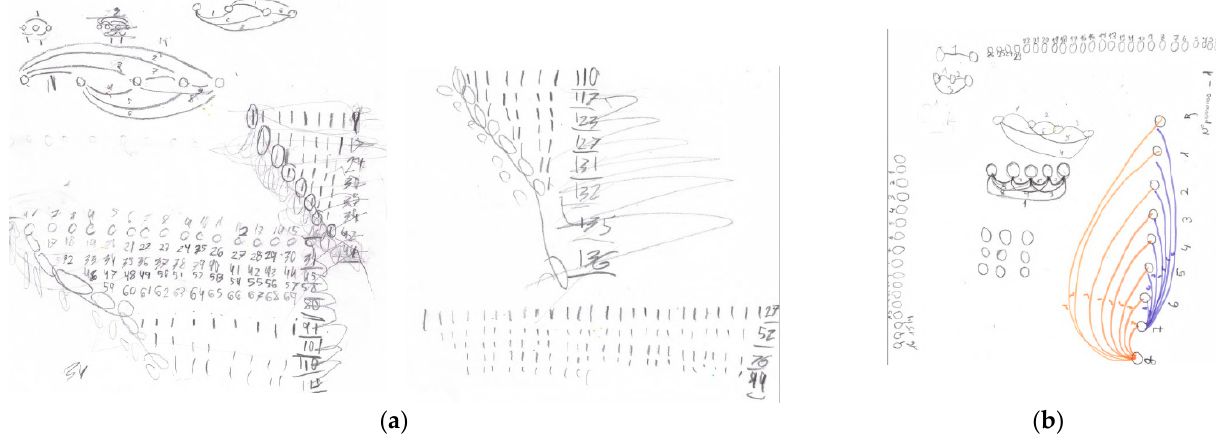
( d ) Figure 7. Star polygons. Drawing made by participant: ( a ) A4; ( b ) A5; ( c ) A6; ( d ) A7.